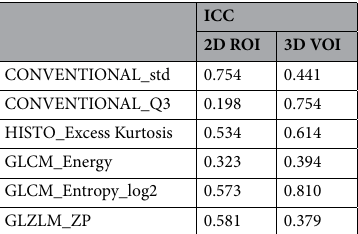
Table 7. Individual intraclass correlation coefficient (ICC) values for the most statistically relevant